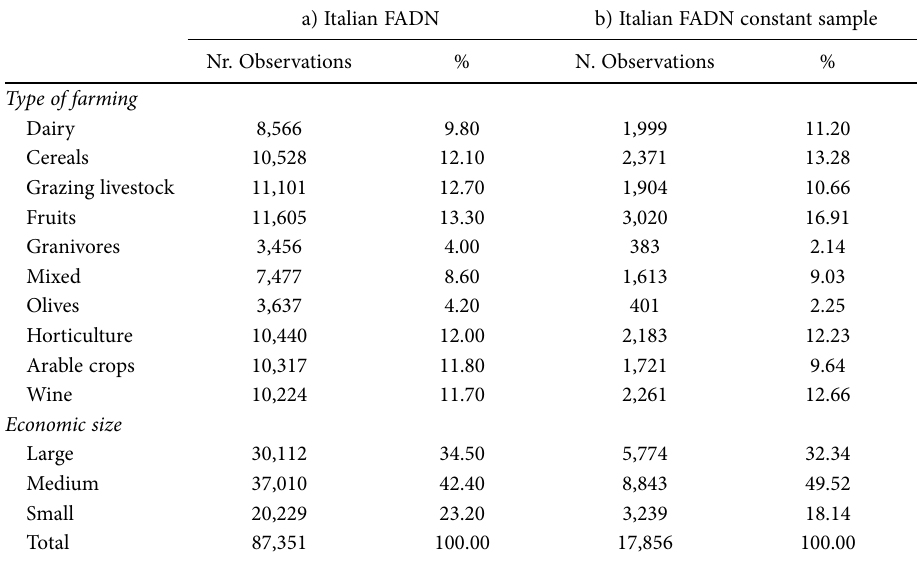
Table 1. Numbers and shares of observations in the FADN sample 2008-2015 by typology and size: a) full Italian sample and b) constant